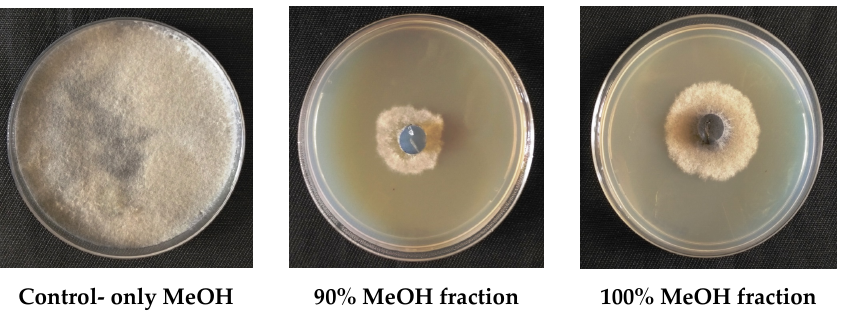
Figure 6. Inhibitory activity of the purified metabolite (90% and 100% MeOH fractions of the open column chromatography) of S. albus CAI-21 against M. phaseolina .